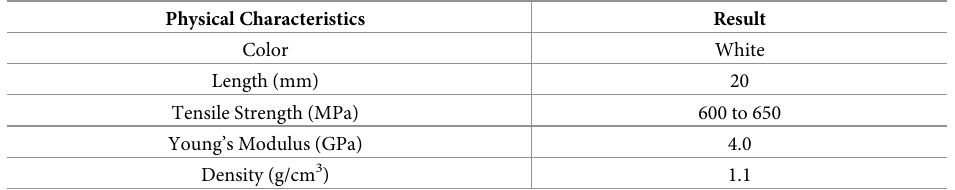
Table 3. Physical characteristics of polypropylene fibers (PPFs).